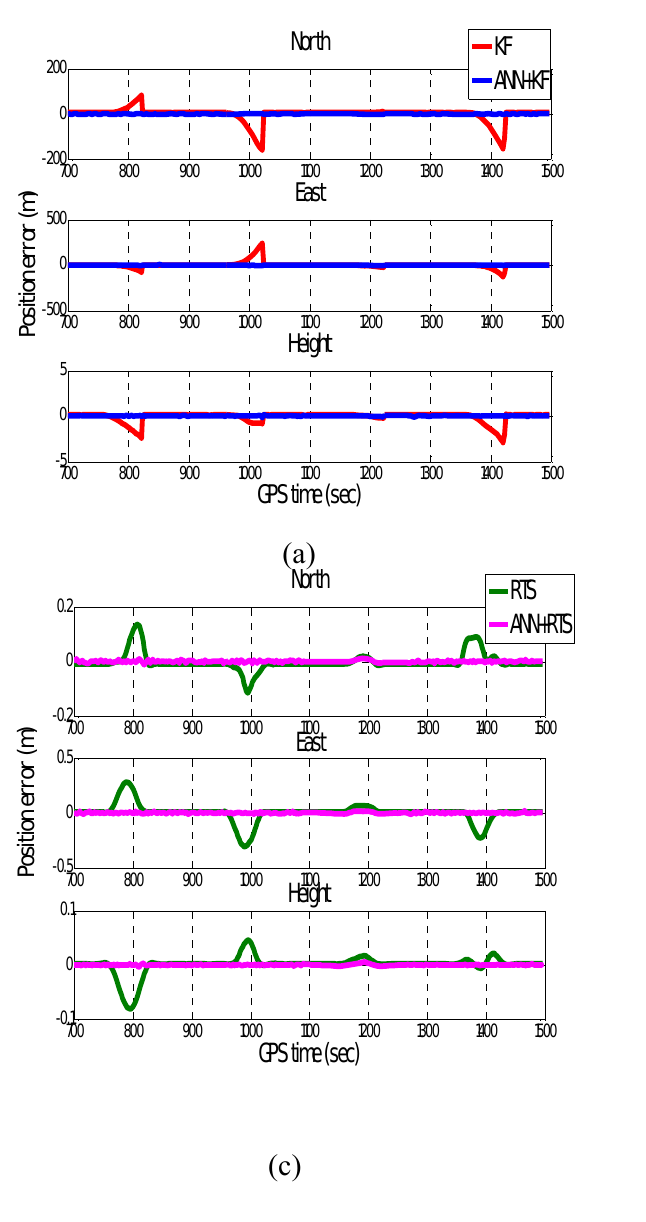
Figure 14. The samples of training results (Trajectory